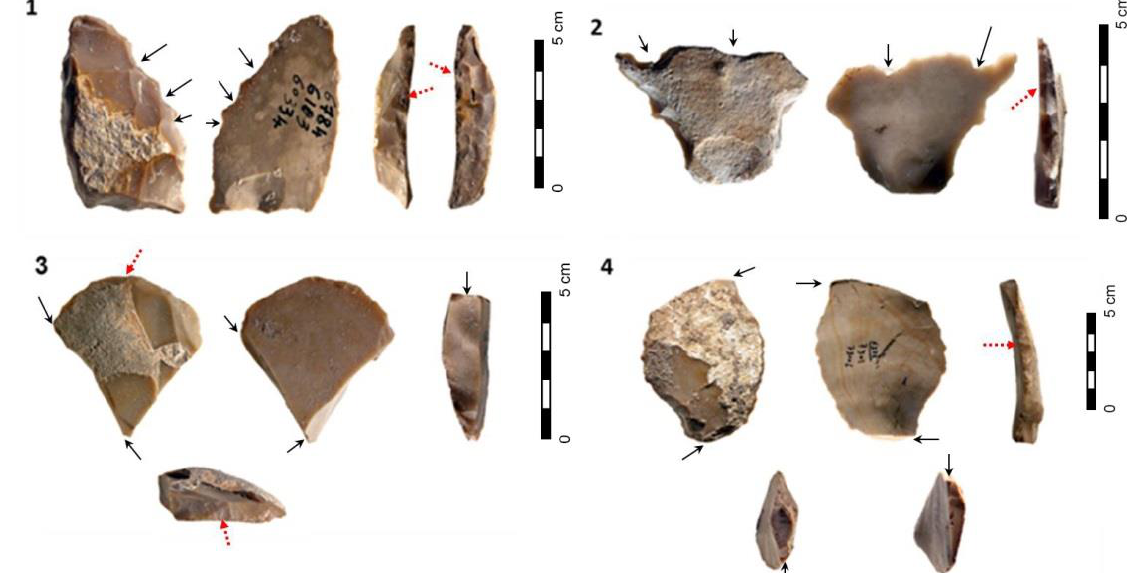
Figure 3. Examples of recycled Fan scrapers. In all the cases presented here, items are Fan scraper due to the cortex, contour and retouch, that were discarded, selected again and show post scraper removals: (1&2) show notch removals ( i.e. , the scrapers were recycled into notched flakes); while (3&4) show burin removals ( i.e. , the scrapers were recycled into burins). Black arrows indicate post scraper removals ( i.e. , the recycling procedure); Red dotted arrows indicate the scrapers retouch ( i.e. , the previous stage of the items before the recycling